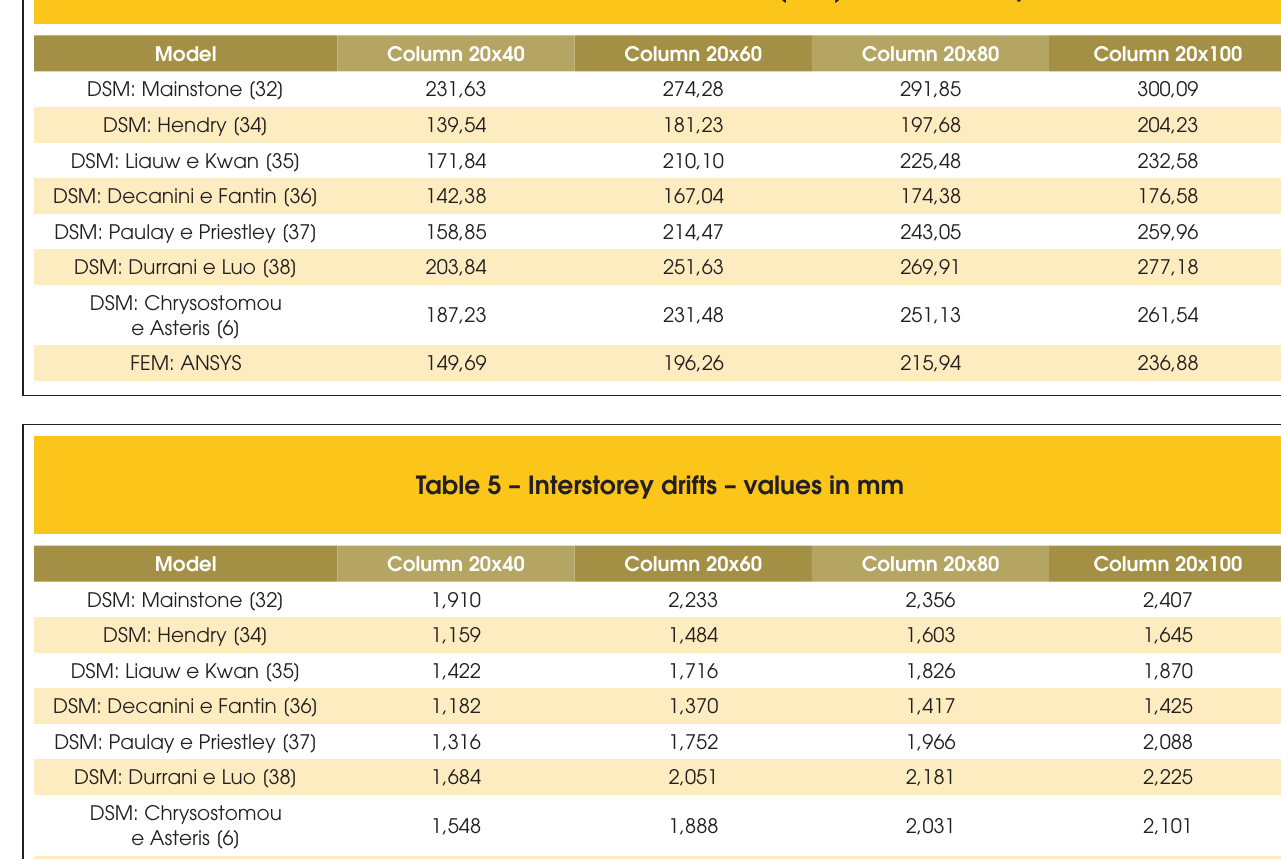
Table 4 – Compressive average stresses (DSM) and compressive principal stresses near to the center of the infill walls (FEM) – values in kN/m 2